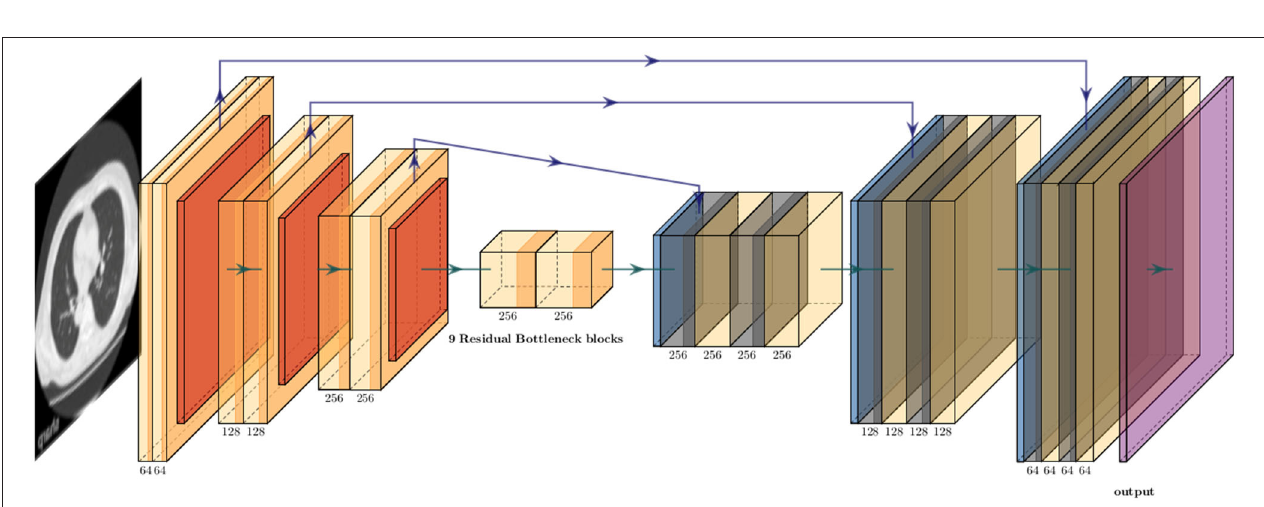
FIGURE 2 | Schematic explanation of deep neural convolutional network in this study. The network consisted of three down-sampling layers followed by nine bottleneck layers of residual blocks flowed by three up-sampling layers. The instance normalization and the ReLU activation function were applied to each layer expect the last. The arctan function was applied as the final activation. Skip connections were formed between the corresponding down and up layers.